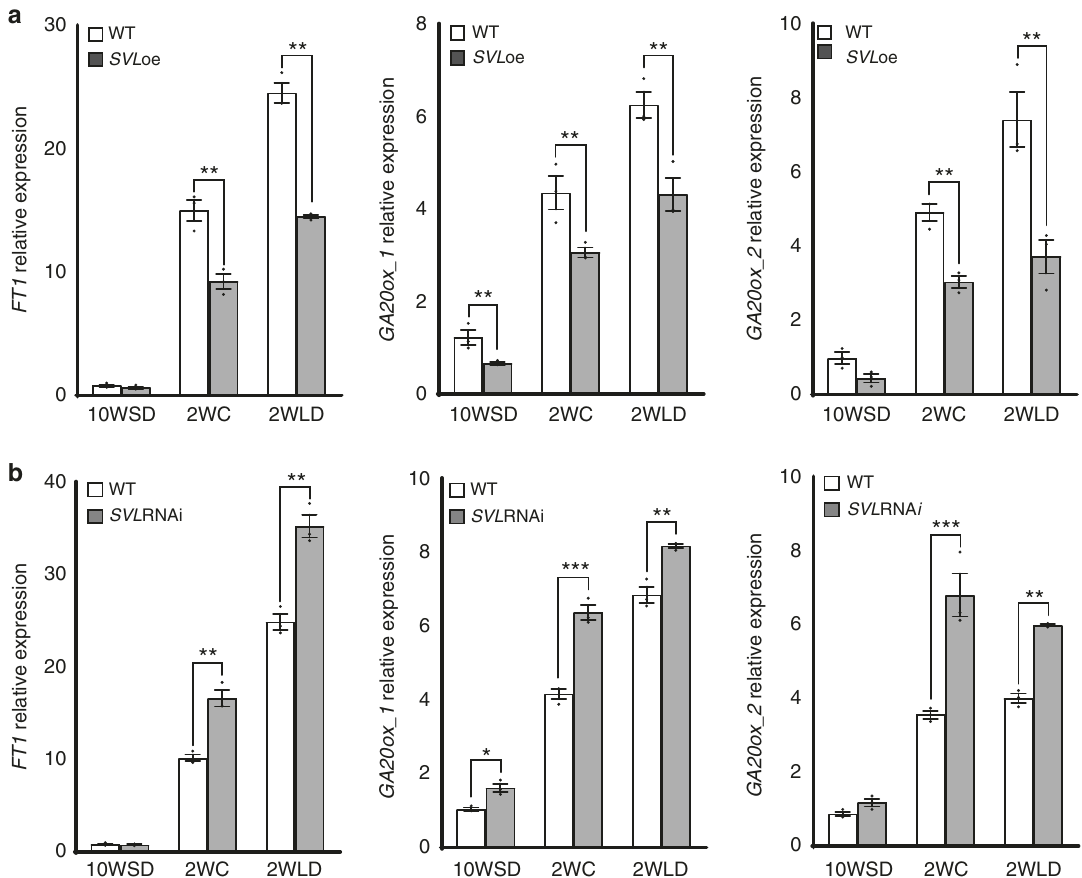
Fig. 2 SVL negatively regulates expression of FT1 and GA20 oxidases during dormancy release and bud break. Expression patterns of genes encoding FT1 , GA20 oxidases ( GA20ox_1 and GA20ox_2 ) in apices of a WT and SVL oe and b WT and SVL RNAi after 10 weeks of SDs(10WSD), at the time of dormancy release (i.e. after 2weeks of LT, 2WC), and after 2 weeks subsequent exposure to long days and warmer temperatures (2WLD). Expression values of the cited genes shown are averages for three biological replicates ± SEM, relative to the reference gene UBQ and with 10WSD time point set to 1. Asterisks indicate signi fi cant (* P < 0.05), very signi fi cant (** P < 0.005) and extremely signi fi cant (*** P < 0.001) differences from corresponding controls, respectively. Statistical analysis was done using multiple t